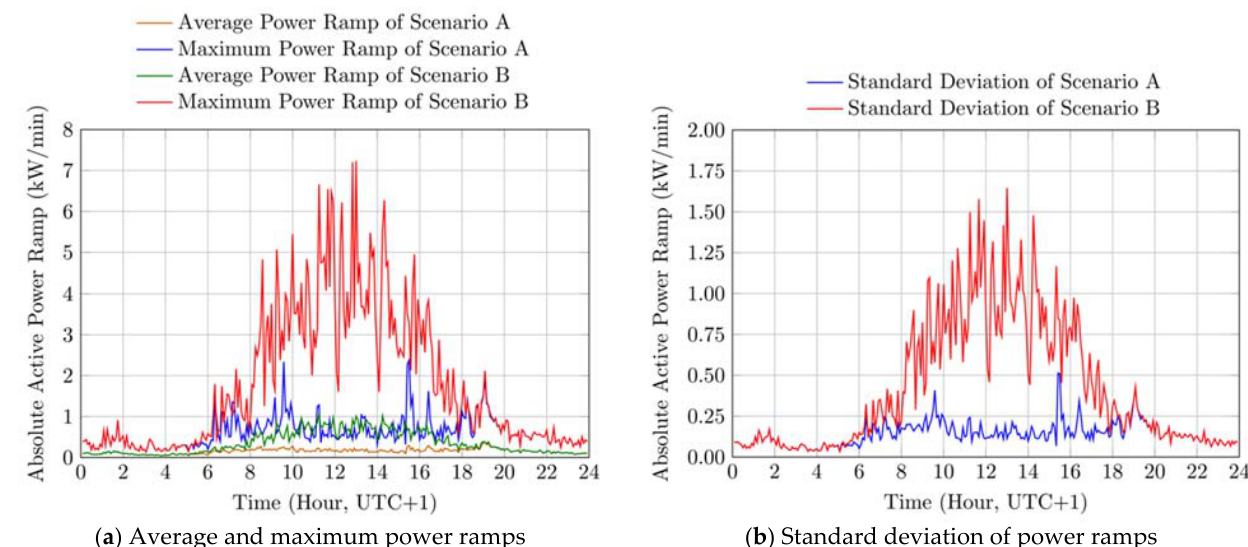
Figure 6. Absolute power ramp of the active net power flow at the PCC with the main grid for Scenarios A and B during May 2020. In sub-figure ( a ), the average and maximum values of the power ramp are shown, while sub-figure ( b ) reports the standard deviation of the measurements for each i -th time interval. UTC: universal time coordinated.